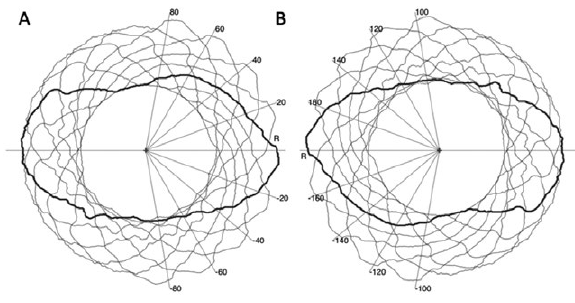
Fig. 4. – In bold letters, representation of the reconstructed contours from C coefficients when, in the incoming image, the otolith was l rotated with respect to the AFORO positional normalization by A, between –90° and 90° and B, between 90° and